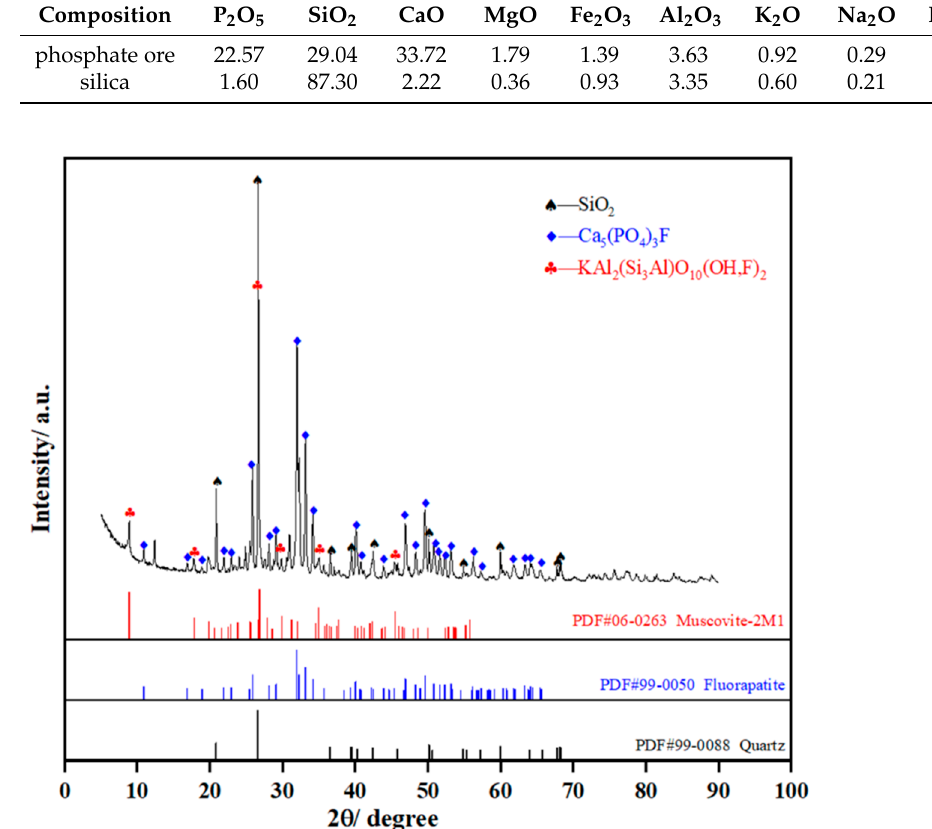
Table 1. Chemical compositions of the phosphate ore and silica (mass fraction, wt %). Table 2. Chemical compositions of coke ash (mass fraction, wt %).